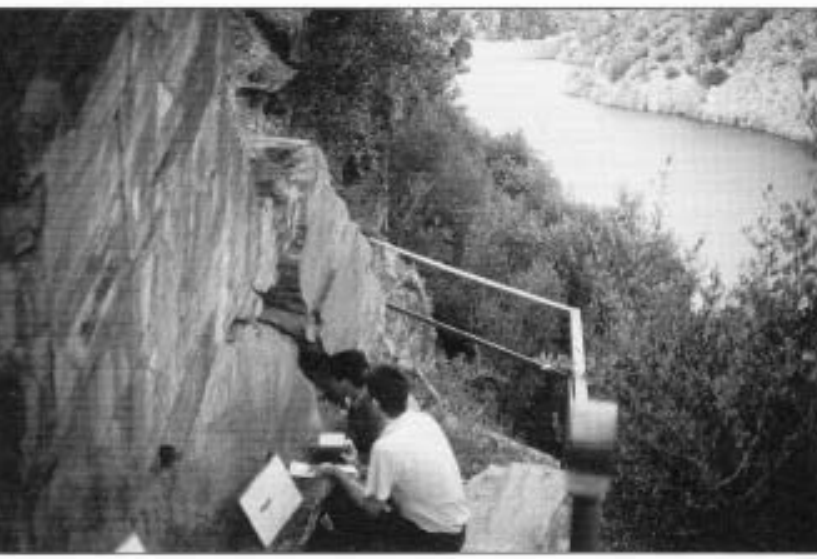
Figure 8 The Coa Valley: engraving of two horses with their heads intertwined (the height of the horse on the right is approximately 0.5m).